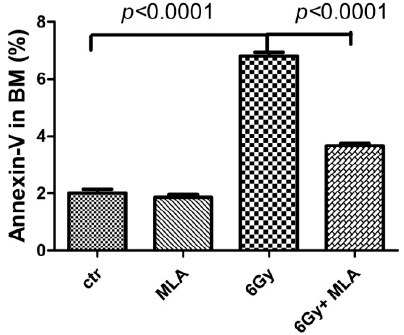
Figure 5. Effects of MLA on apoptosis in BMMNCs. Before the mice were exposed to 6 Gy TBI, they were treated with either vehicle or MLA (10 mg/kg) each day three times. Sham-irradiated control mice and MLA-treated mice were also included. BMMNCs were collected on day 9 and stained with Annexin V-FITC to evaluate apoptosis by flow cytometry. Results are expressed as the mean ± SEM. The p value shows the difference compared with the IR group.